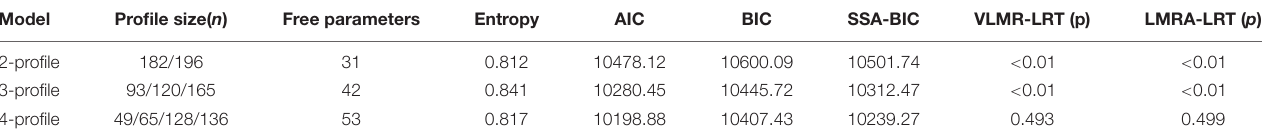
TABLE 4 | Fit statistics for latent profile